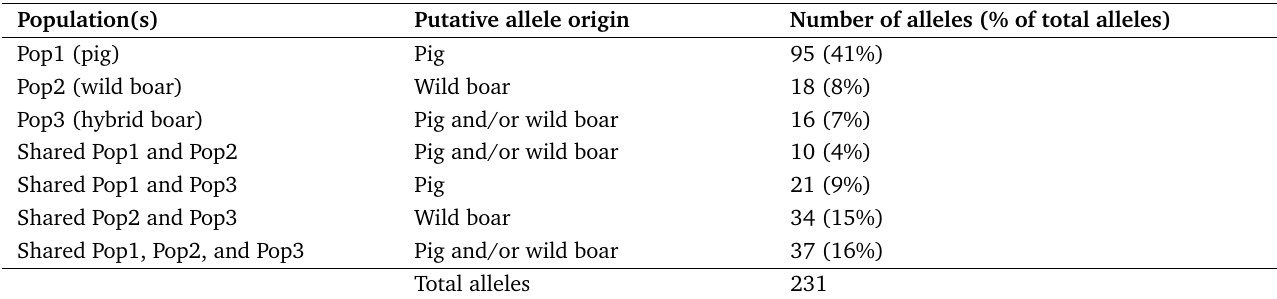
Table 3. Number of putative and shared alleles by population with putative allele origin. Percentage indicates proportion of alleles related to total alleles detected in this